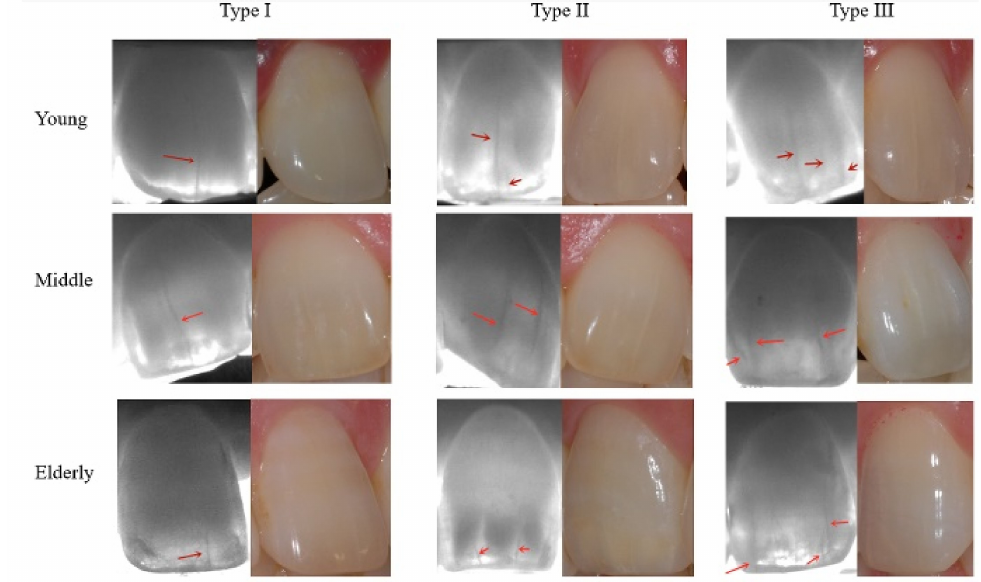
Figure 2. The three most representative types of teeth in the three age groups. The red arrow points out the enamel cracks. The high contrast of the enamel cracks in the near-infrared image can be clearly